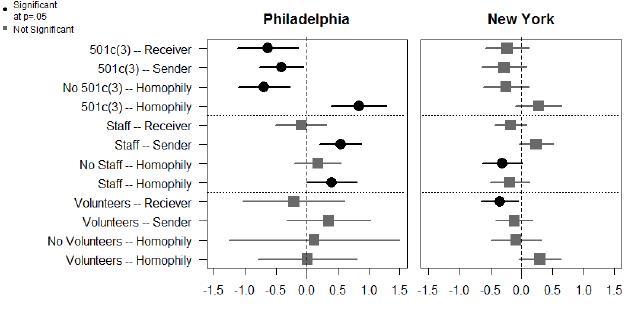
Fig. 5 . Odds ratios for exponential random graph (ERG) terms for Organizational Characteristics in Philadelphia and New York City ERG